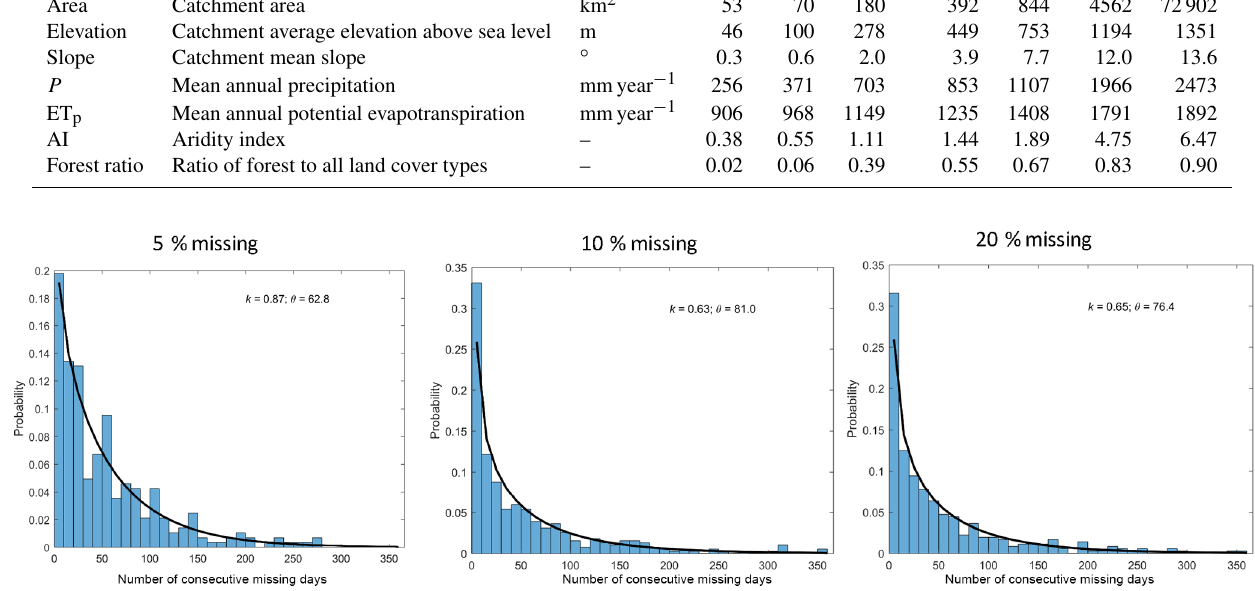
Figure 3. Missing data patterns for three groups of catchments with missing data rates of 4%–6%, 8%–12%, and 18%–22%, which are represented by 5%, 10%, and 20% missing data rates,